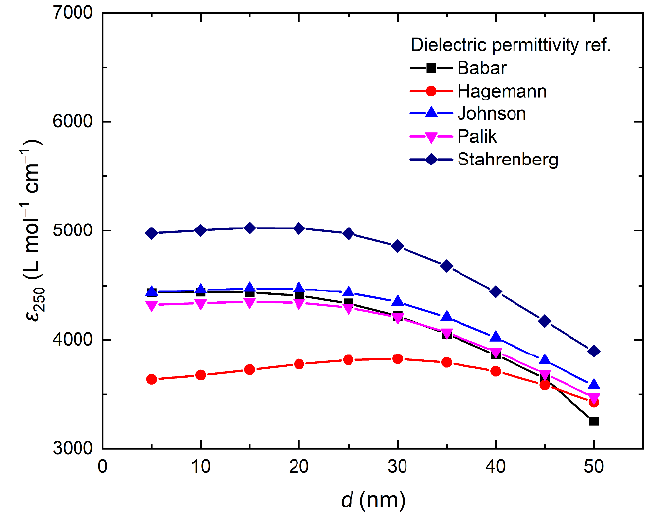
Figure 9. Molar extinction coefficient of Ag 0 at 250 nm (IBT absorption) as a function of nanoparticle